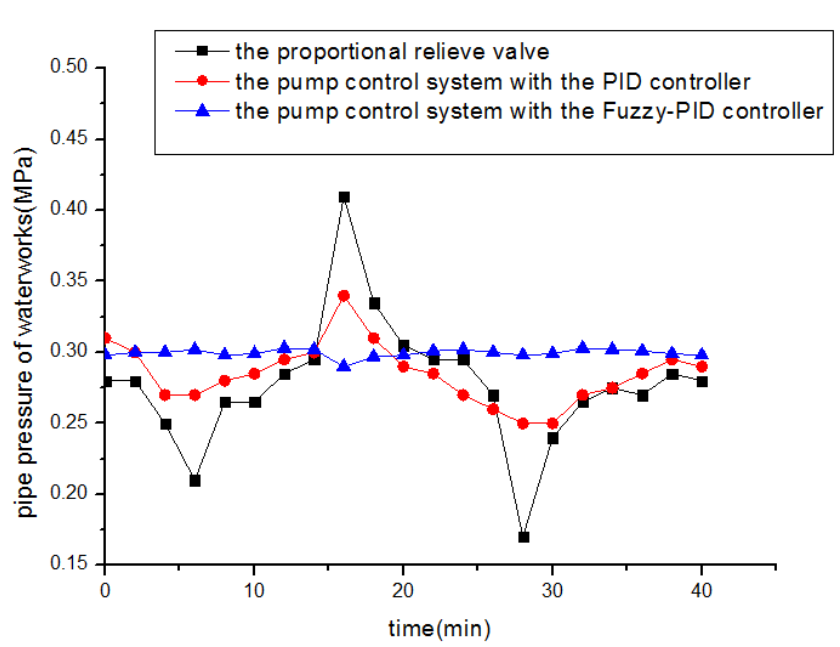
Figure 13. Pipe pressure fluctuation when transmission ratio = 0.84.